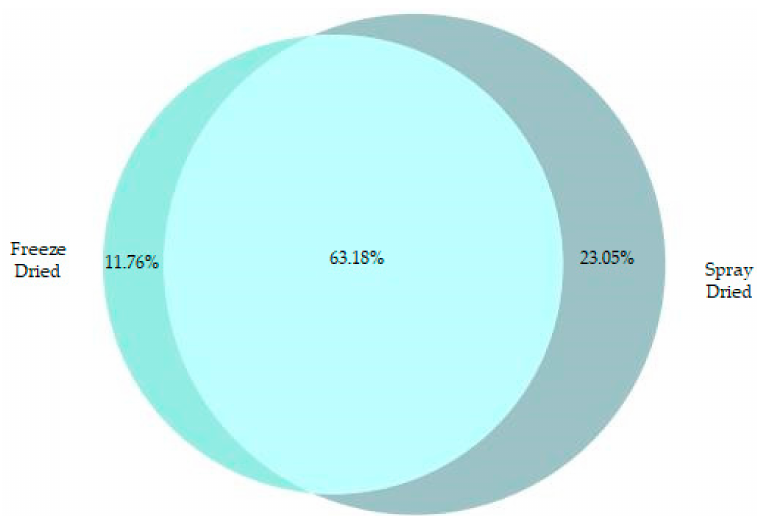
Figure 6. Predicted anti-inflammatory peptides in SD and FD samples. Venn diagram illustrating the percentage of anti-inflammatory peptides common to SD and FD samples (turquoise), unique to SD (blue) samples and unique to FD samples (teal) as a total of all predicted anti-inflammatory